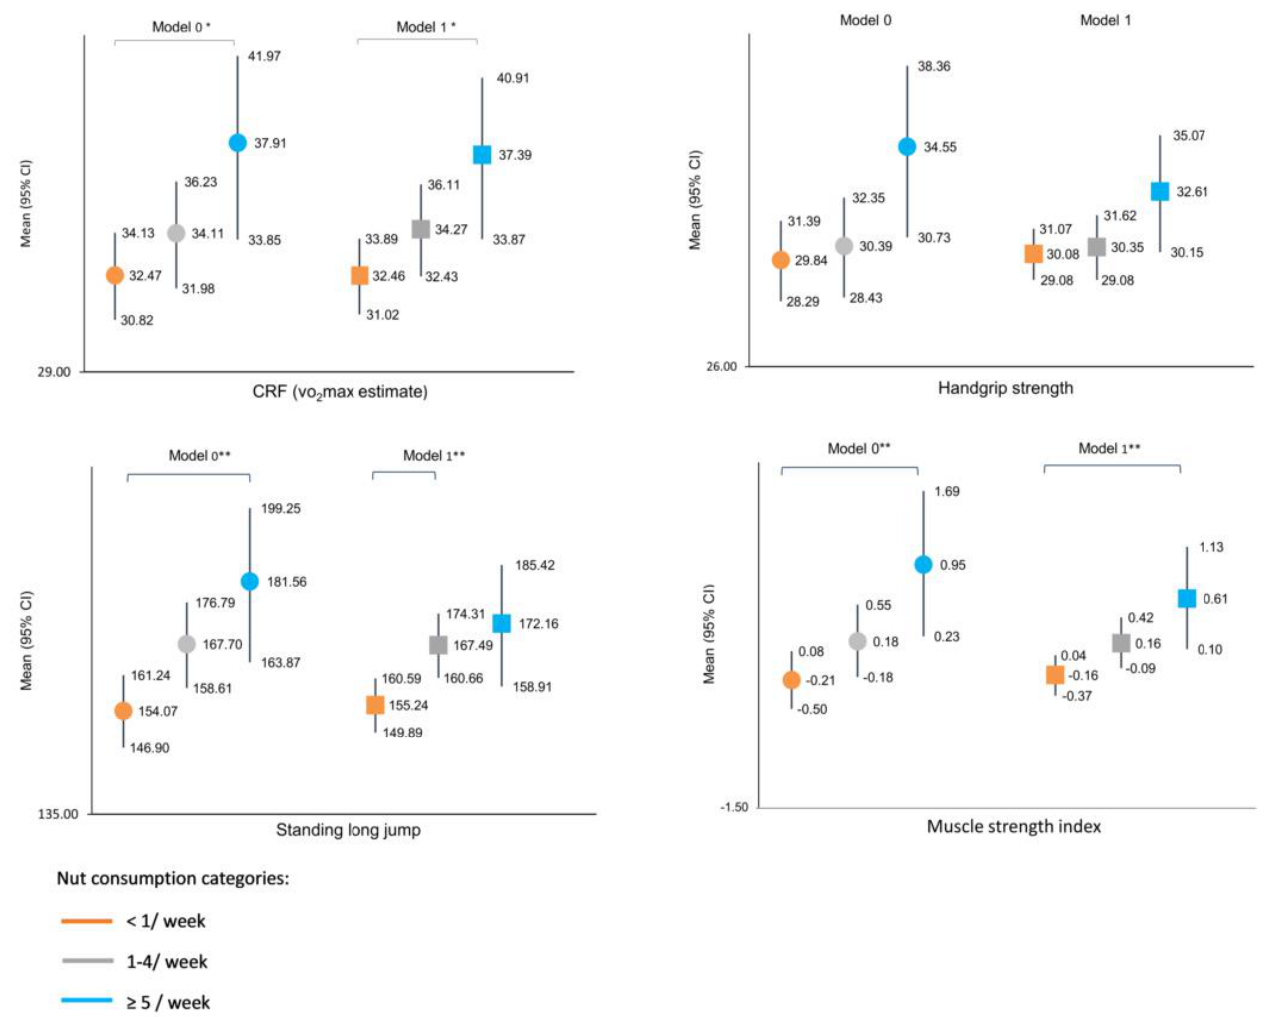
Figure 1. Mean difference and 95% confidence intervals in physical fitness parameters (CRF, handgrip strength, standing long jump and muscle strength index) by categories of nut consumption. О : Model 0: Crude data; □ : Model 1: Adjusted by age and sex. * p < 0.05, ** p < 0.001.